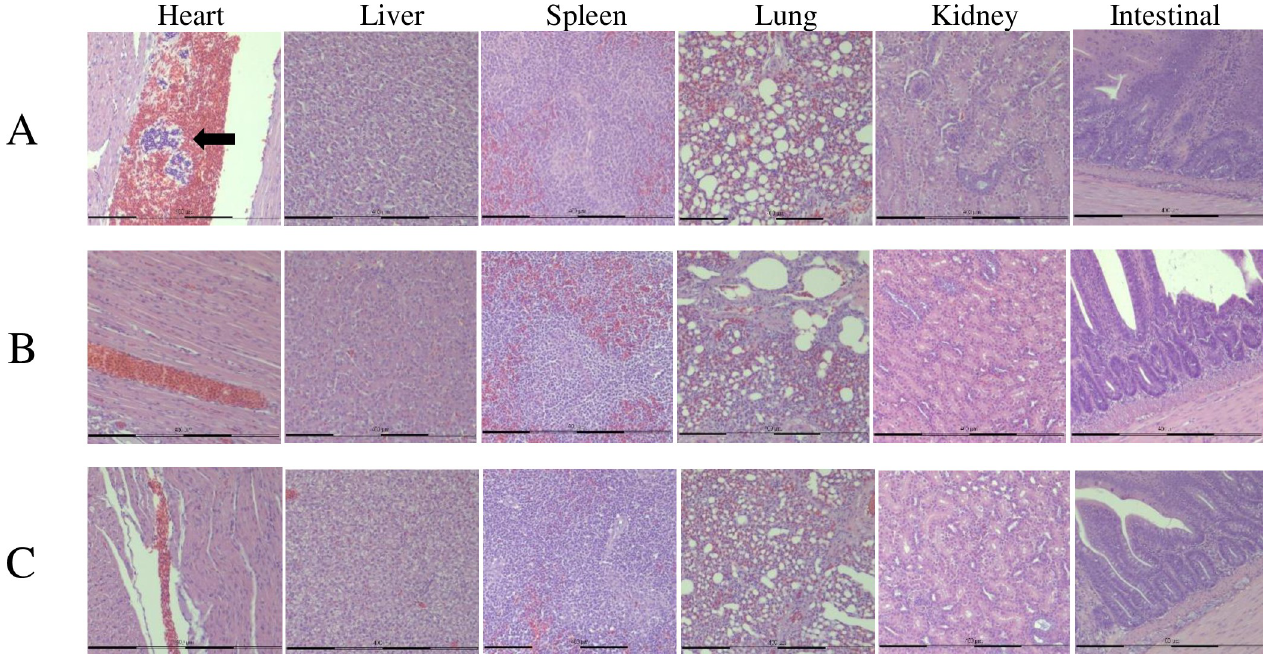
Fig 5. Histological analysis of tissue sections. Representative photomicrographs of tissue sections stained with H&E. A: Spiraline-A group (No. 50); B: 3% rTP4 group (No. 99); C: Basal diet group (No. 90).